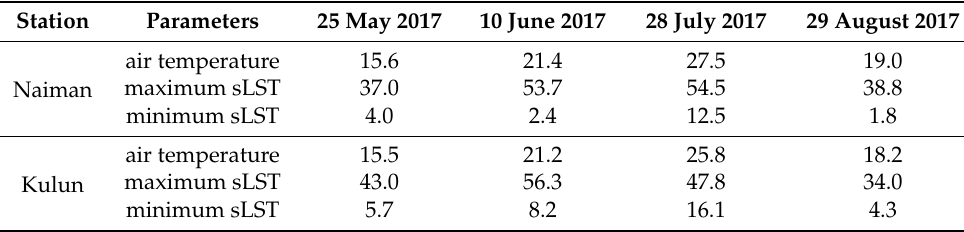
Table 1. Meteorological observatory data recorded by field meteorological stations corresponding to acquisition period of Landsat 8 images/( ◦